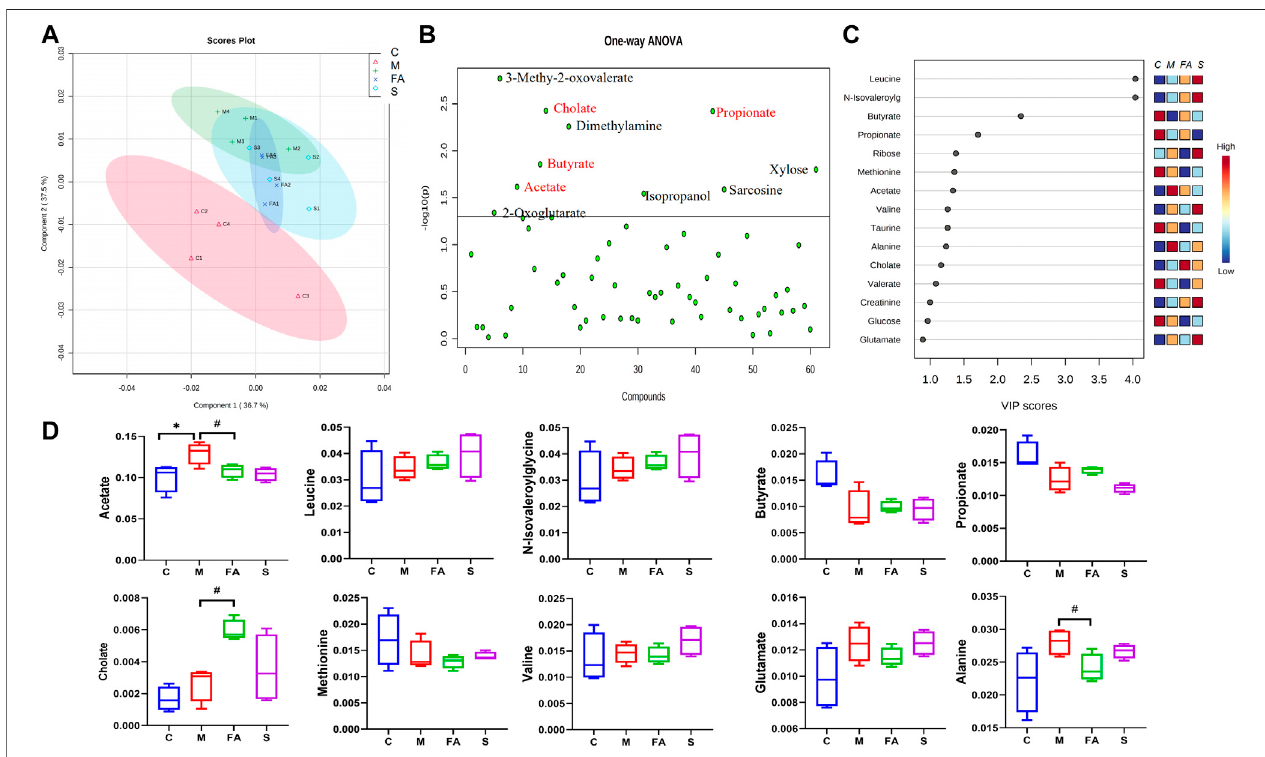
FIGURE 8 | The Effect of FA on gut microbiota metabolite in ApoE − / − mice. (A) The PLS-DA Scores plots in per group. (B) One-way ANOVA plots of metabolite among groups. The metabolite above the horizontal line had a difference among groups with p < 0.05. (C) The metabolites with VIP values > 1.0 were regarded as important. Red and blue indicated increased and decreased levels, respectively. (D) The content of differential metabolites (acetate, leucine, butyrate, propionate, Cholate, valine, Glutamate and alanine) among groups ( n (cid:2) 4). # p < 0.05; as compared to the model group.